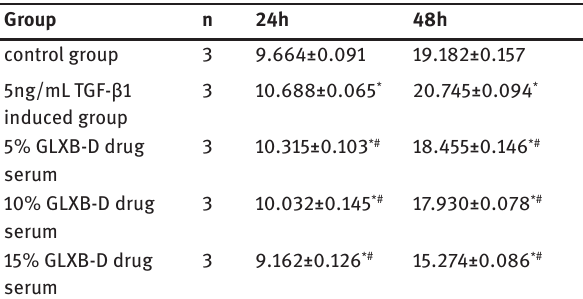
Table 2: The effects of different concentrations of GLXB-D drug serum on the expression of Collagen I in A549 cells (n=3, x±s). Group